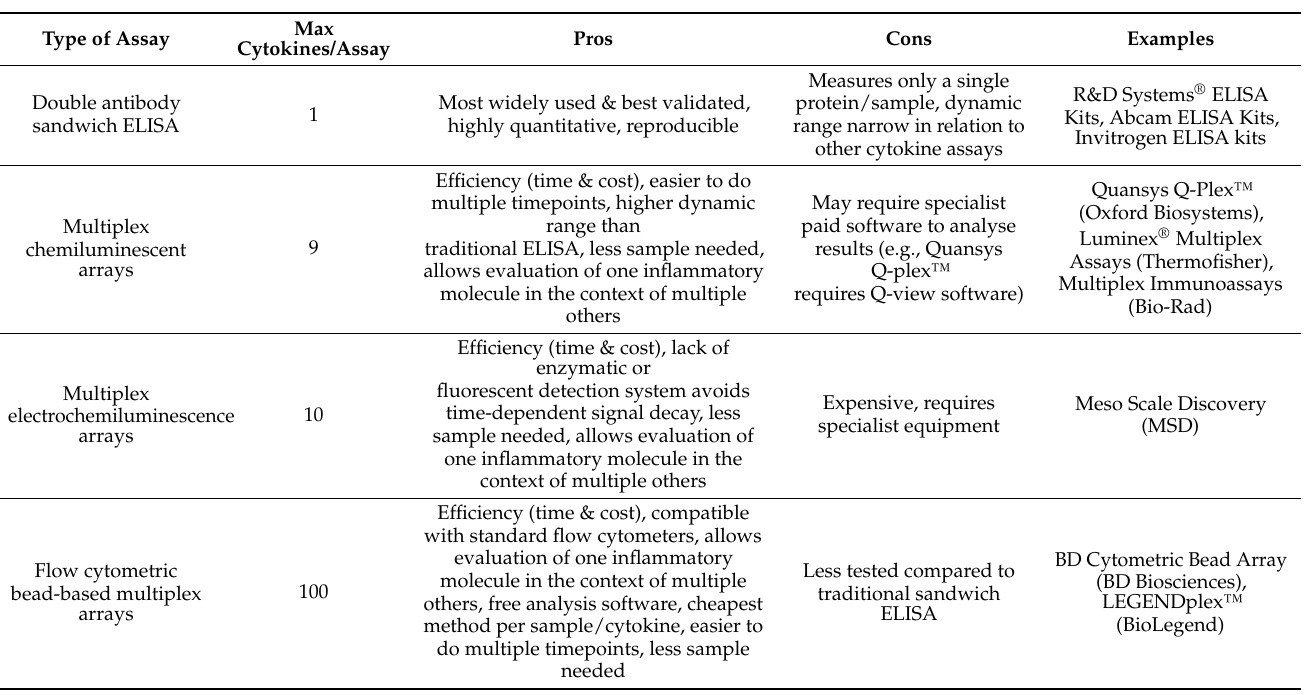
Table 2. Summary of the different techniques used to quantify cytokine release from microglia, as well as pros and cons of each technique and examples of products. ELISA = enzyme-linked immunosorbent